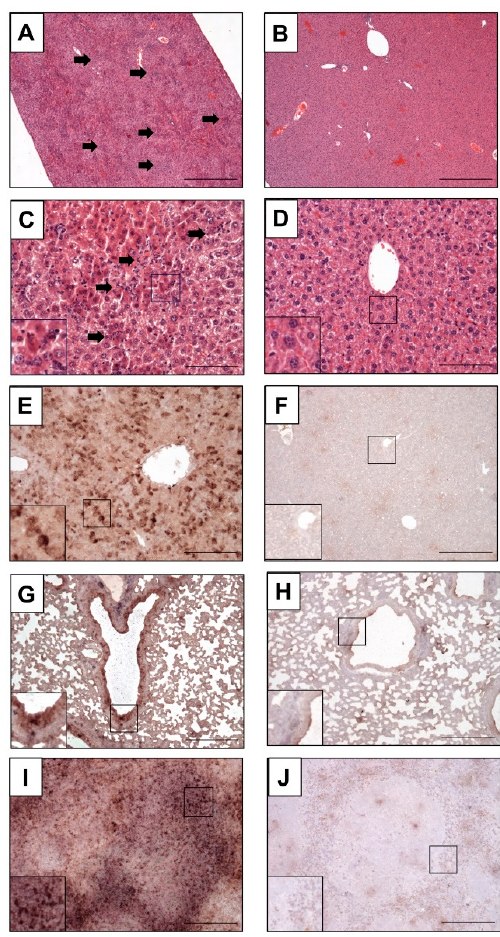
Figure 5 . Histopathological examination of infected mice. ( A , C , E , G , I ) Mock-vaccinated control mice (PBS) compared to MVA-EBOV-NP-vaccinated mice ( B , D , F , H , J ); ( A – D ) H&E staining, ( G – J ) in situ hybridization with digoxigenin-labeled RNA probes binding to EBOV GP mRNA, brown staining; ( A – F ): liver, ( G , H ): lung, ( I , J ): spleen. Livers of PBS mock-vaccinated mice ( A , C ) showing randomly distributed hepatocellular necrosis and lymphohistiocytic infiltrations (arrows). Insert: magnifica- tion of selected areas; Scale bar ( A , B ): 500 µm; ( C , D ): 100 µm; ( E – J ): 200 µm.